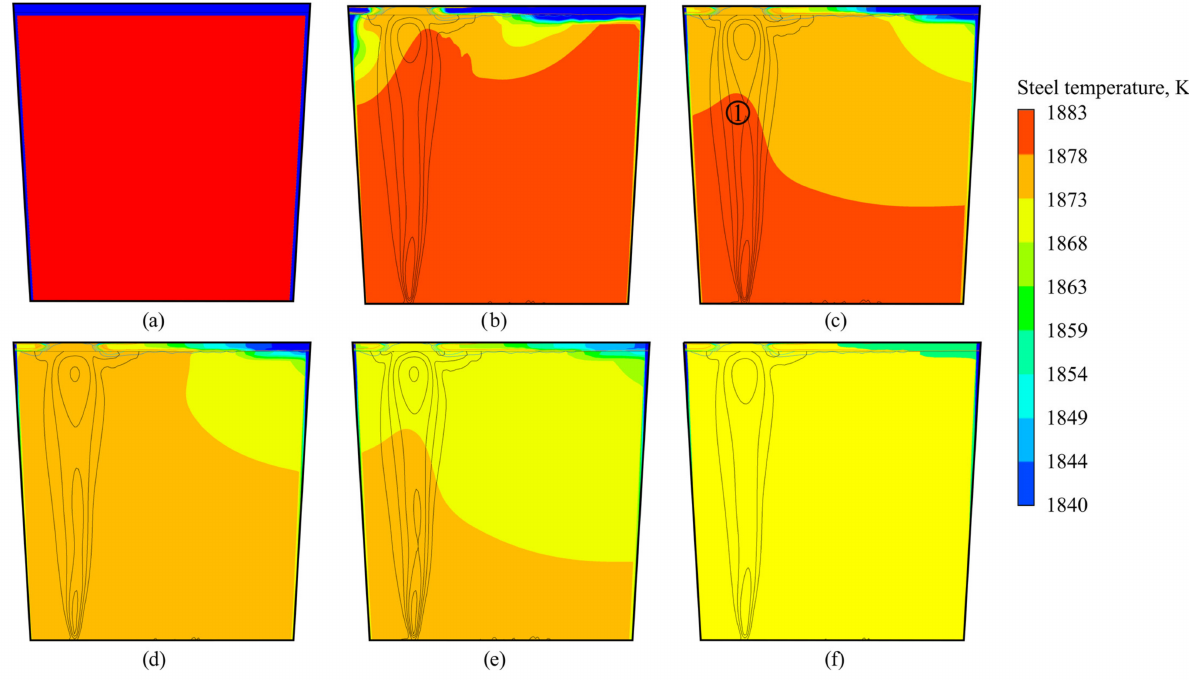
Figure 9. Steel temperature contours at ( a ) start of calculations, ( b ) 0.5 min, ( c ) 1 min, ( d ) 1.5 min, ( e ) 2 min, and ( f ) 2.5